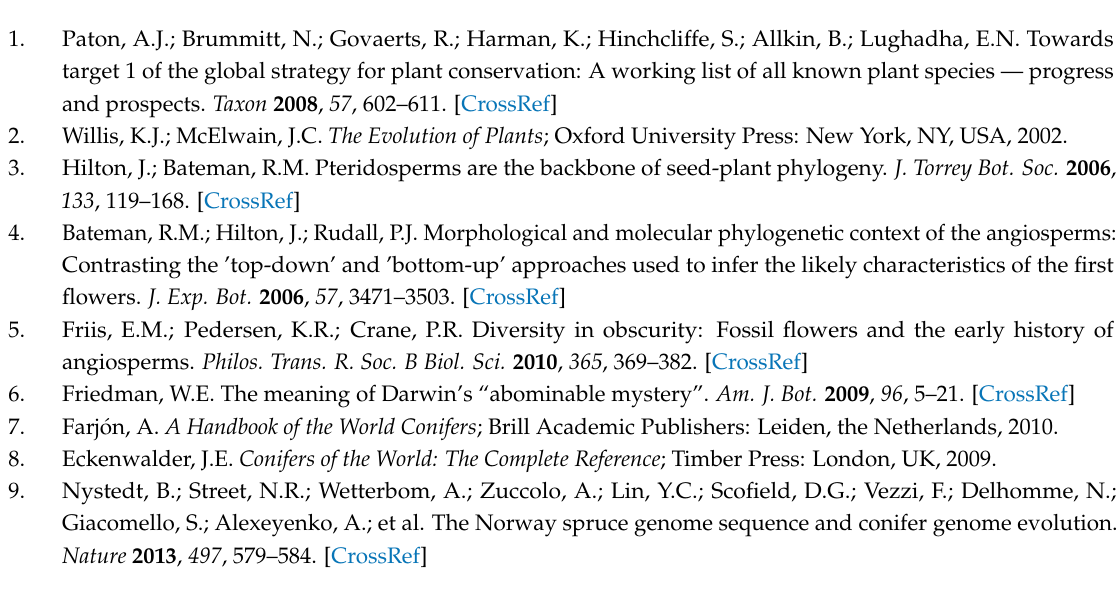
Table S1: Details of sequenced tree genomes (as of February